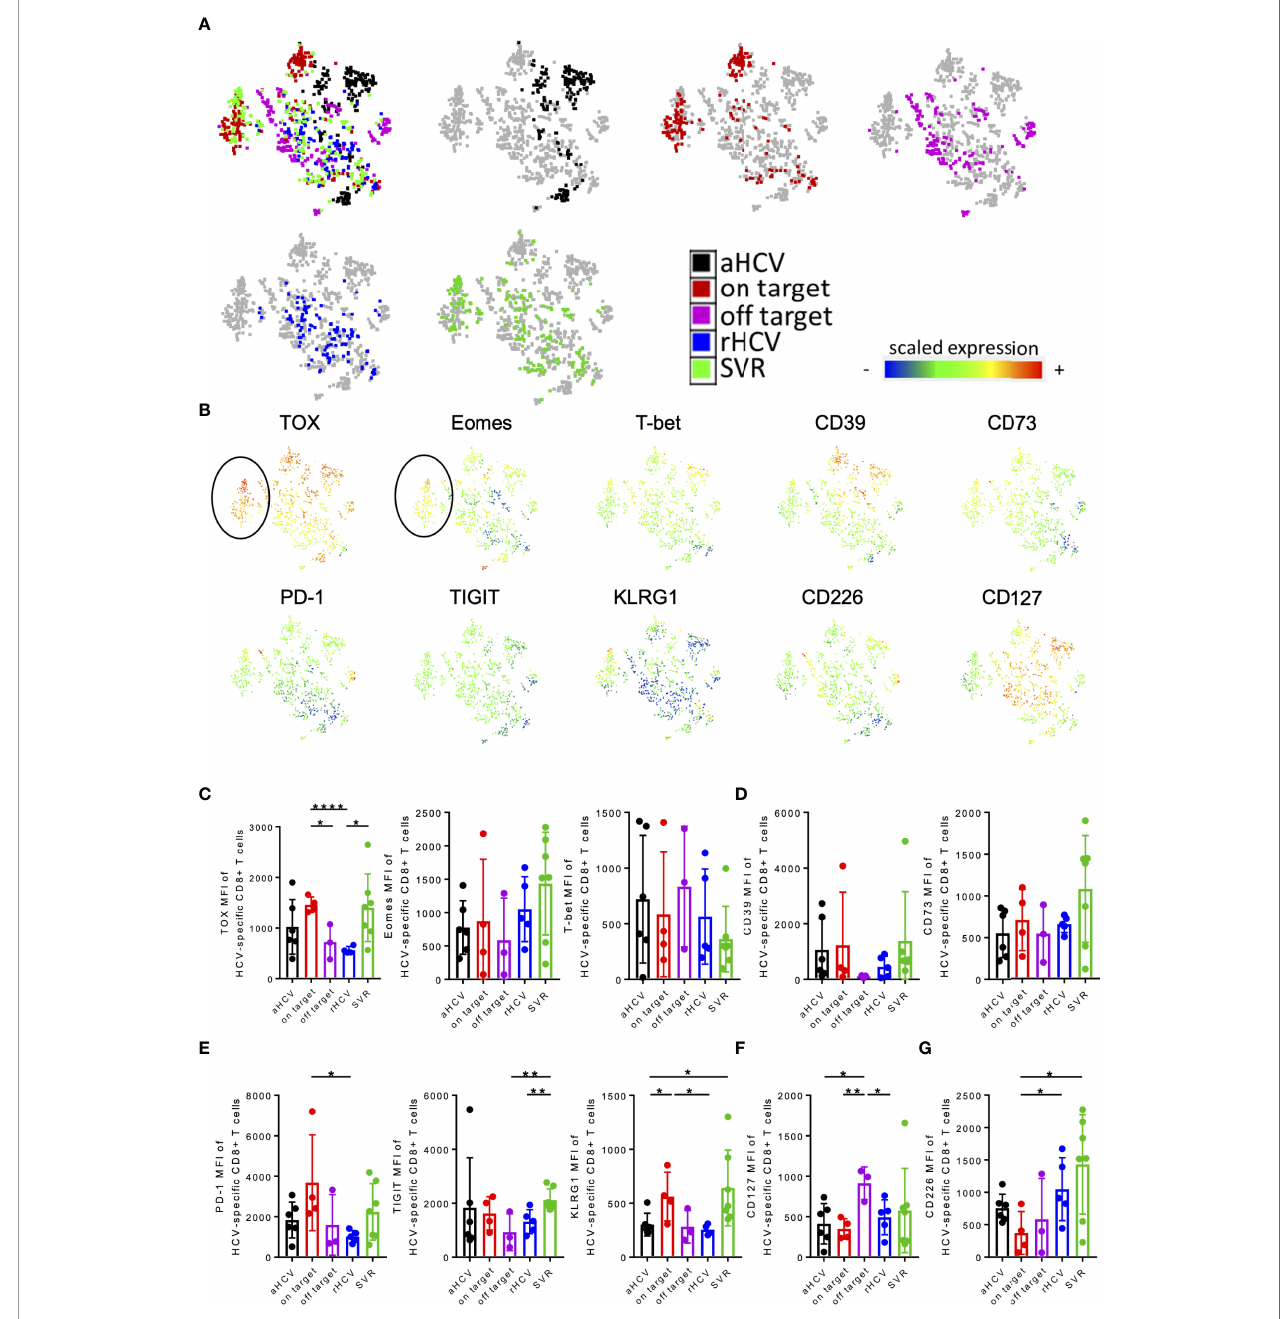
FIGURE 2 | (A – F) tSNE and MFI analysis of virus-speci fi c CD8+ T cells of patients aHCV, cHCV (on-target T cells and off-target T cells), rHCV, and SVR. (A) A 2- dimensional map of virus-speci fi c CD8+ T cells concatenated from all selected samples was generated by t-SNE analysis. Samples from aHCV (black), cHCV (on- target; red), cHCV (off-target; purple), rHCV (blue), and SVR (green) patients were projected onto the total sample map. (B) The expression levels (measured as mean fl uorescence intensities) of the indicated markers were projected onto the t-SNE map. (C – G) MFI levels of the indicated markers. Data are shown as mean ± SD, where *, **, and **** indicate P values <0.05, <0.01, and